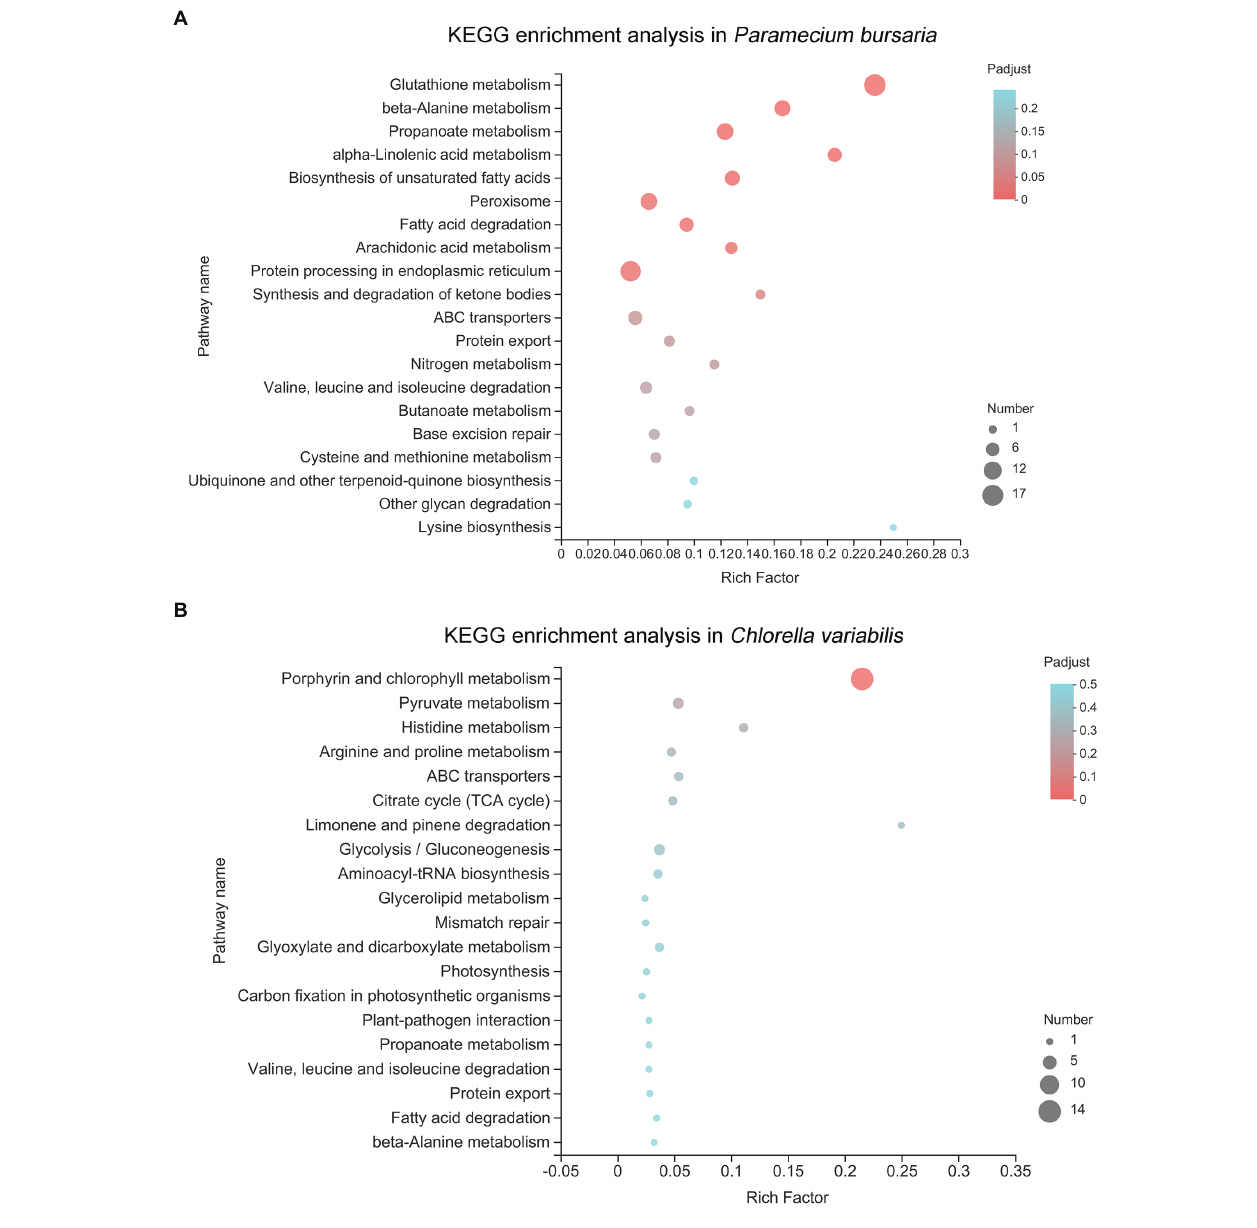
FIGURE 6 | The Kyoto Encyclopedia of Genes and Genomes (KEGG) pathway analysis of differential expressed genes in P. bursaria (A) and C. variabilis (B) . The y -axis represents pathways and the x -axis represents the enrichment score. The color and size of each bubble represent the enrichment significance and the number of genes enriched in the pathway,